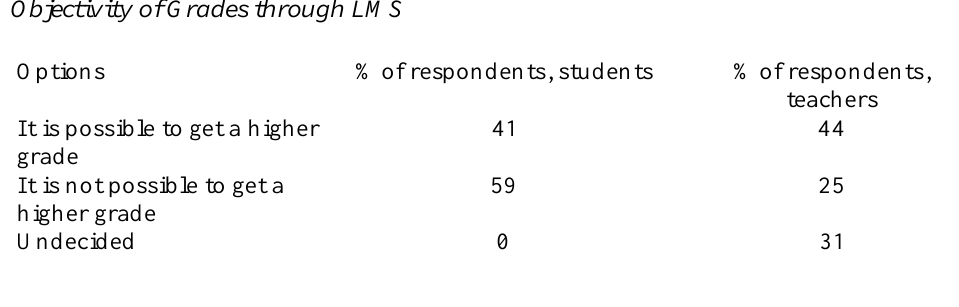
Objectivity of Grades through